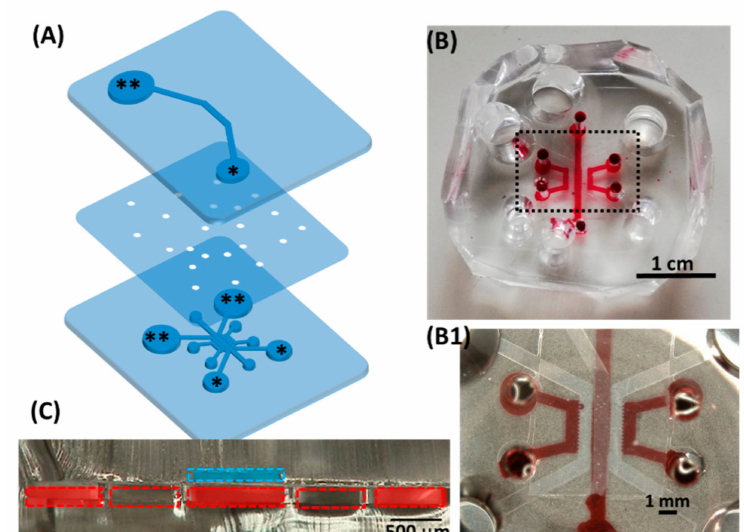
Figure 1. Configuration of the proposed device. ( A ) Exploded view; medium reservoirs are marked with asterisks (** as inlets, * as outlets when loading cells or media). ( B ) Top view of the assembled device, with dye water in some of the lower microchannels. ( B1 ) Magnified view of the black dashed box in ( B ), showing the central part of the device overlaying the single top microchannel and multiple lower microchannels. ( C ) Microscopic cross-sectional view of the assembled two-layer device. The dashed blue line indicated the top microchannel; each dashed red box indicated the lower microfluidic channels separated by micropillars. Red rectangles in the lower channel corresponded to where red dye water was loaded. Together, the blue and red rectangles indicate the potential culturing chambers. The detailed dimension is in Figure